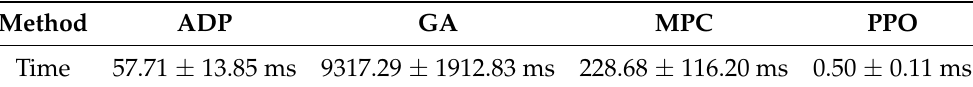
Table 3. Computation time at each time step during the online